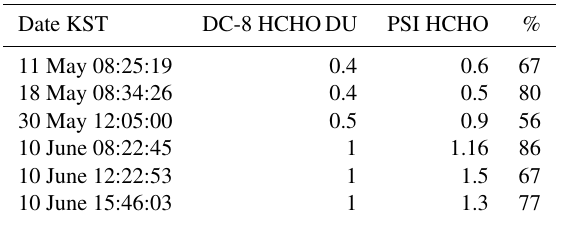
Table 2. Taehwa Mountain. DC-8 compared to PSI measurements in Fig.